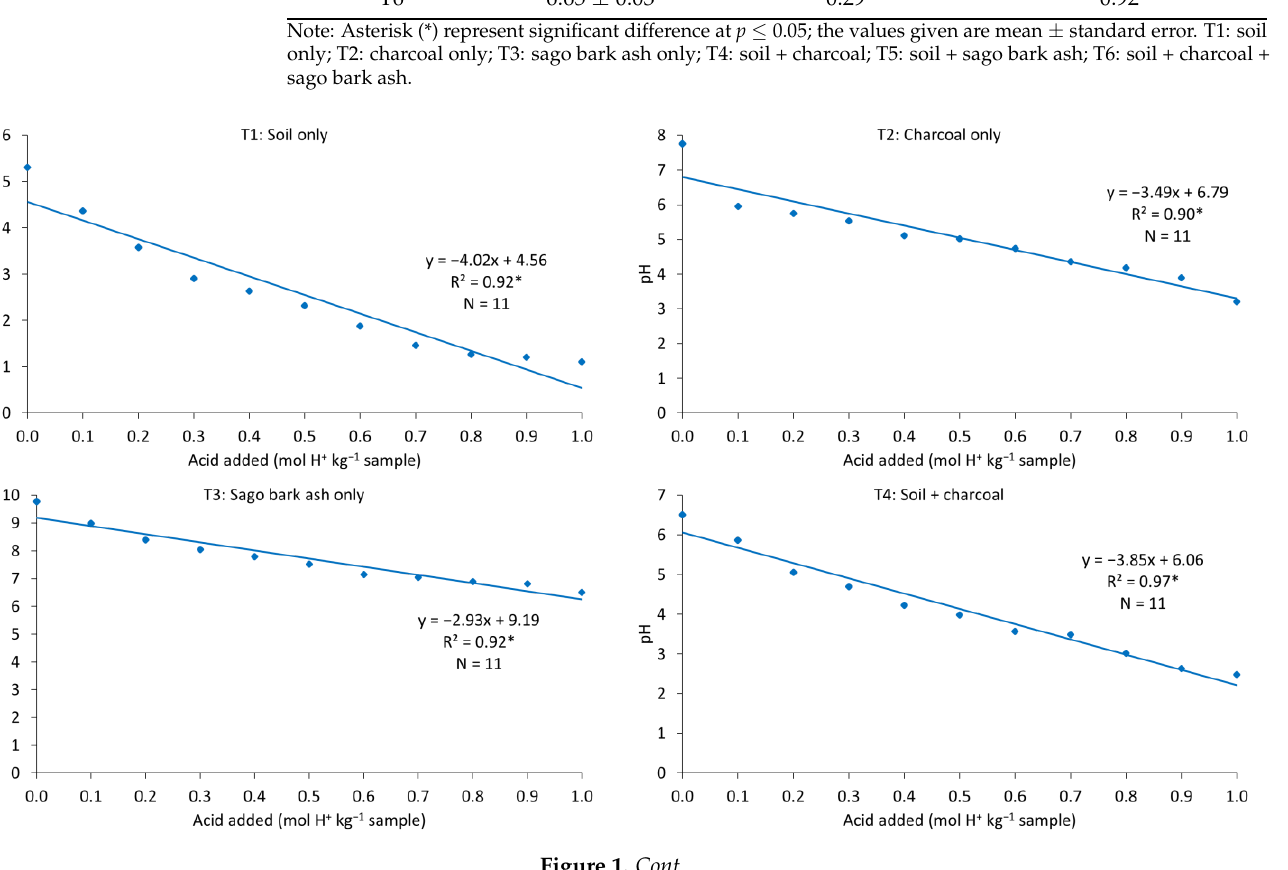
Figure 1. Linear regression between dilute sulphuric acid added (mol H + kg −1 sample) and pH of suspension, where aster- isk (*) represent significant difference at p ≤ 0.05 . 3.2. Treatments on pH and Electrical Conductivity of Leachate over Thirty Days of Leaching Effects of the treatments on the pH of leachates over 30 days of leaching are presented in Figure 2. Leachate of soil alone (S1) recorded the lowest pH throughout the leaching study. This is possible because of the acidic nature of the soil (Table 1) and no ERP in S1. Application of ERP can contribute to the increase in pH because the dissolution of apatite in rock phosphates consumes H + ions. pH of C0A1 leachate (soil with 100% sago bark ash) was the highest, followed by leachate C1A1 (soil with combination of 100% charcoal and 100% sago bark ash). The high pH of these two leachates is attributed to Ca and Mg car- bonates in the sago bark ash, which qualifies the ash as a liming material. Upon applica- tion of ash, change in pH is rapid compared with lime because of the rapidly soluble con- tent of oxides or hydroxides of Ca and Mg of the ash [54]. It was noticed that as the rate of sago bark ash decreased, the pH of leachate decreased. This finding implies that, unlike charcoal, sago bark ash has a significant impact on the alkalinity of leachate, and this is consistent with the higher pH of sago bark ash compared with charcoal (Table 2). pH of the leachates increased after day 10, but after day 15 pH of the leachates decreased, except for E1. The fluctuation of the pH of the leachates might be because of the nonuniformity in the movement of water through the soil during leaching.